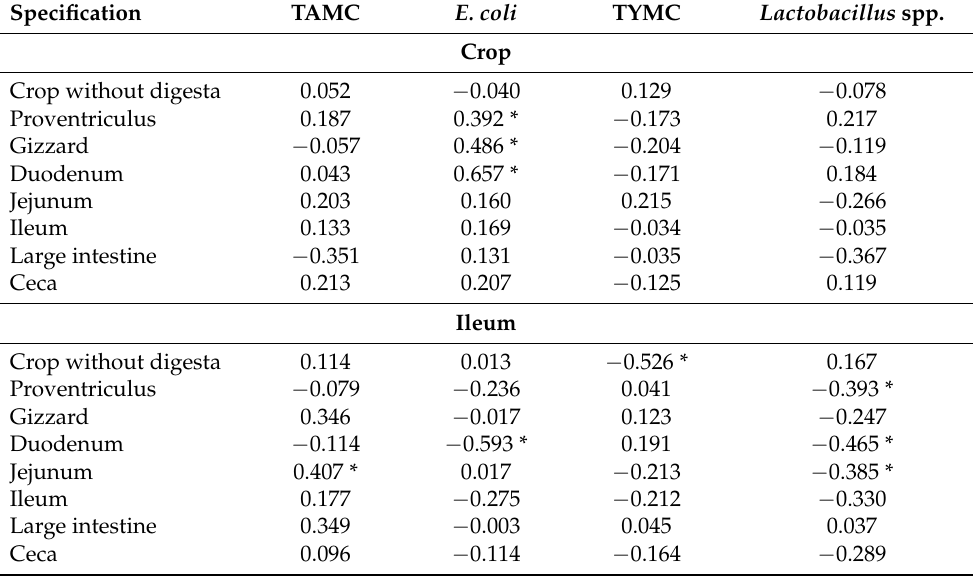
Table 8. Correlation between weights of organs and lengths of sections of intestines and count of microorganisms in crop and ileum